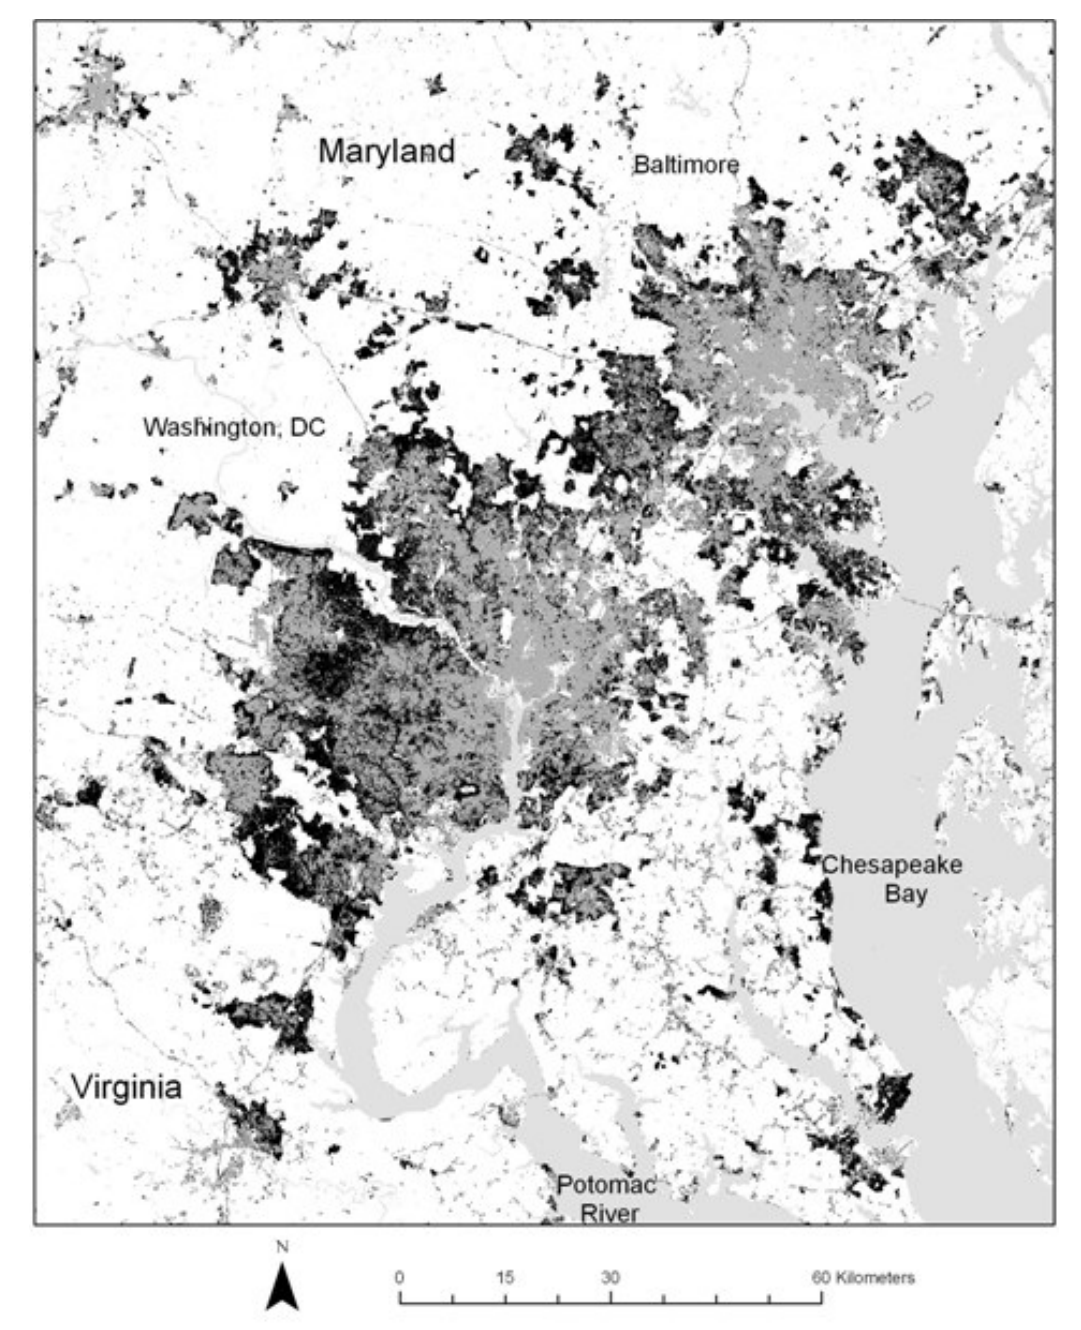
Fig. 2. Urban development as of 2001 (gray) and projected for 2020 (black) in central Maryland and northern Virginia. Projected urban development provided courtesy of D. M. Theobald, Colorado State